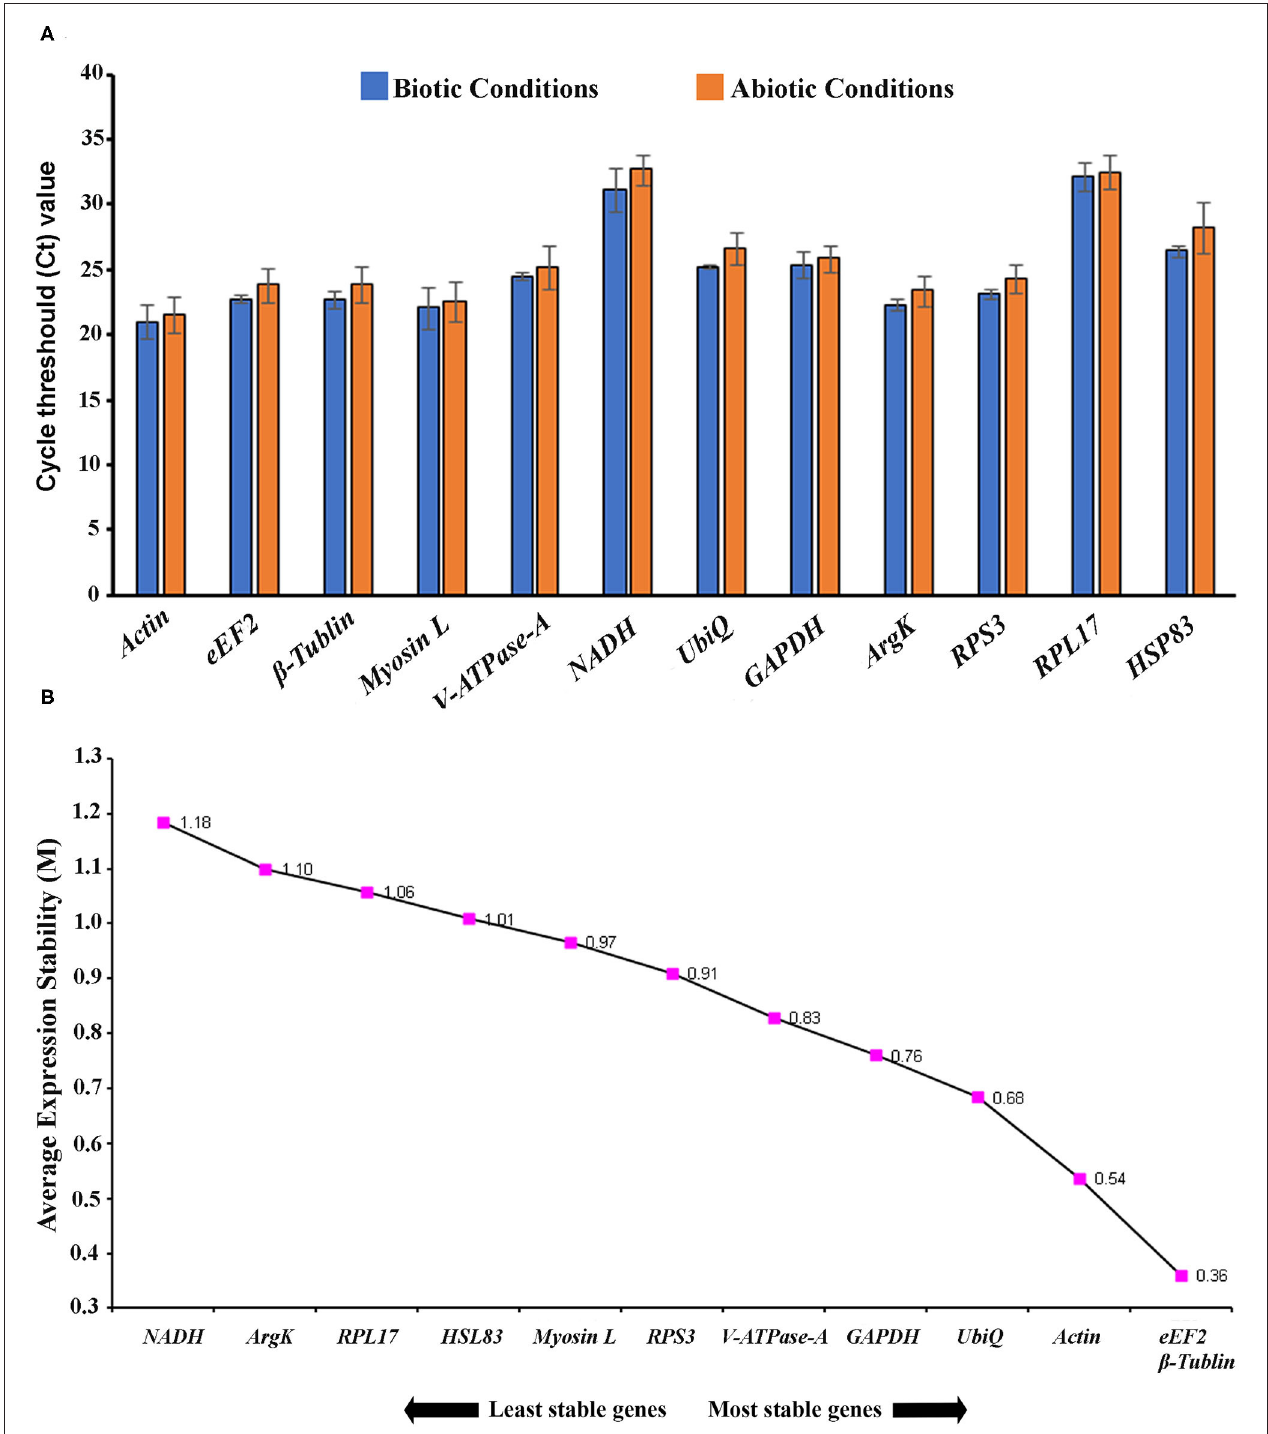
FIGURE 1 | (A) Expression range of cycle threshold (Ct) values of candidate reference genes under different experimental conditions in I. sexdentatus (ISx). The different conditions included in biotic conditions: developmental stages (i.e., larvae, pupae, and adult stages), sex-specific (male and female), tissue types [head, midgut, fat body, and whole body (WB) except head, gut, fat body (Abdomen)] and abiotic conditions: different treatments (such as temperature; Juvenile hormone III; wild-collected vs. long-term laboratory-reared; and different host feeding). (B) The average expression stability values (M) of 12 reference genes in different developmental stages (larvae, pupae, and adult stages) were plotted from the least stable (left) to the most stable (right).